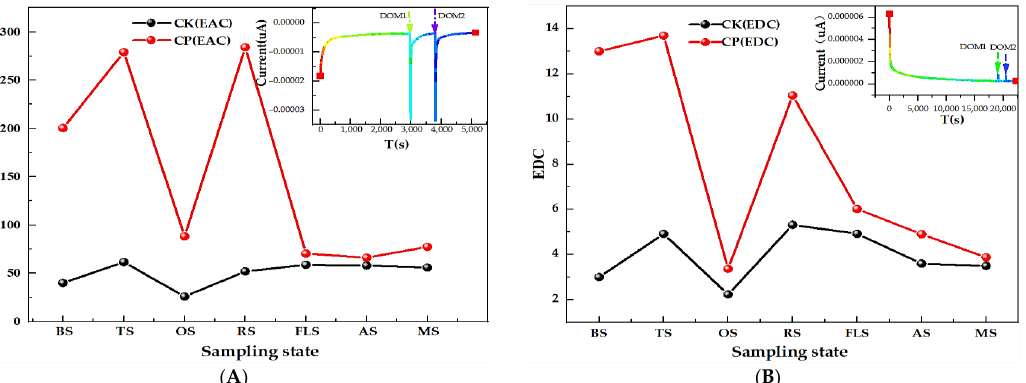
Figure 5. Comparison of EAC and EDC of soil DOM (the nested diagrams represent the chronoam- perometric plots of EAC and EDC, respectively). ( A ) EAC comparison of CK and CP, ( B ) EDC com- parison of CK and CP .